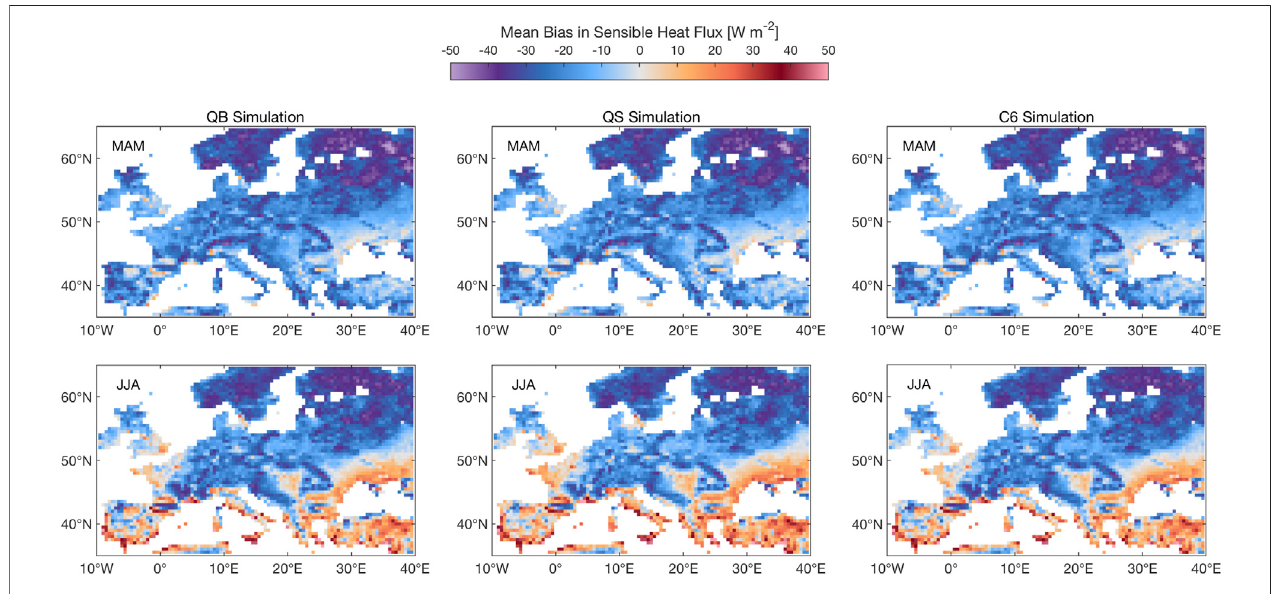
FIGURE 5 | Same as Figure 3 , albeit for sensible heat. Units: W m − 2